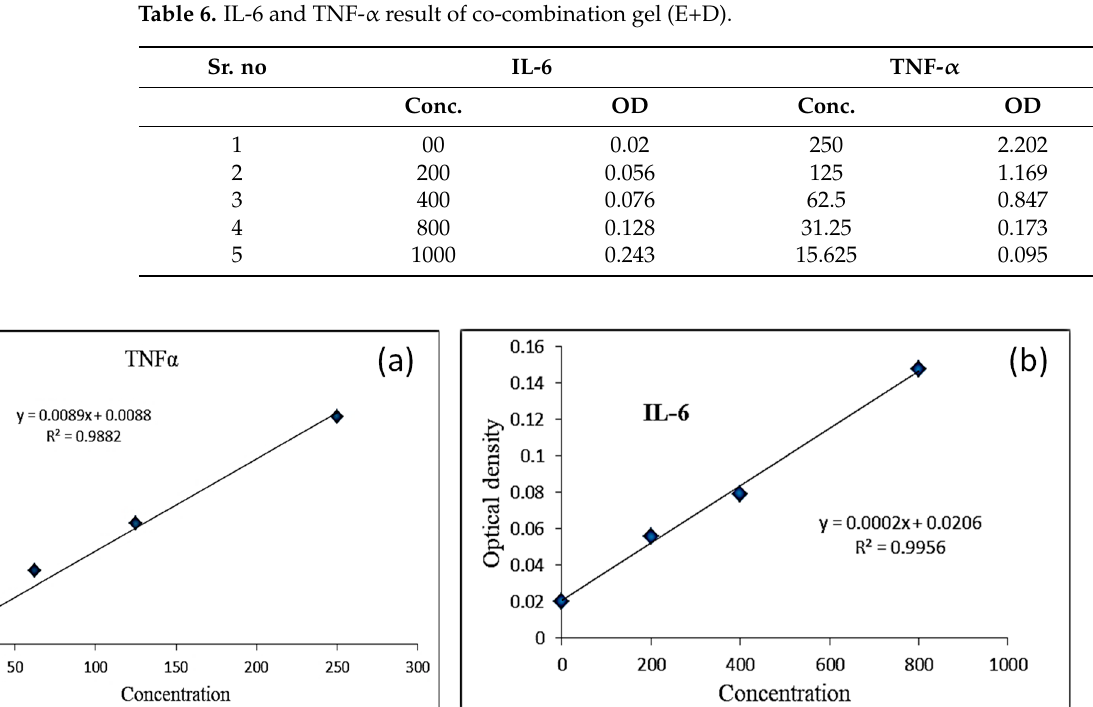
Figure 9. Standard curve of ( a ) TNF α and ( b ) IL-6.